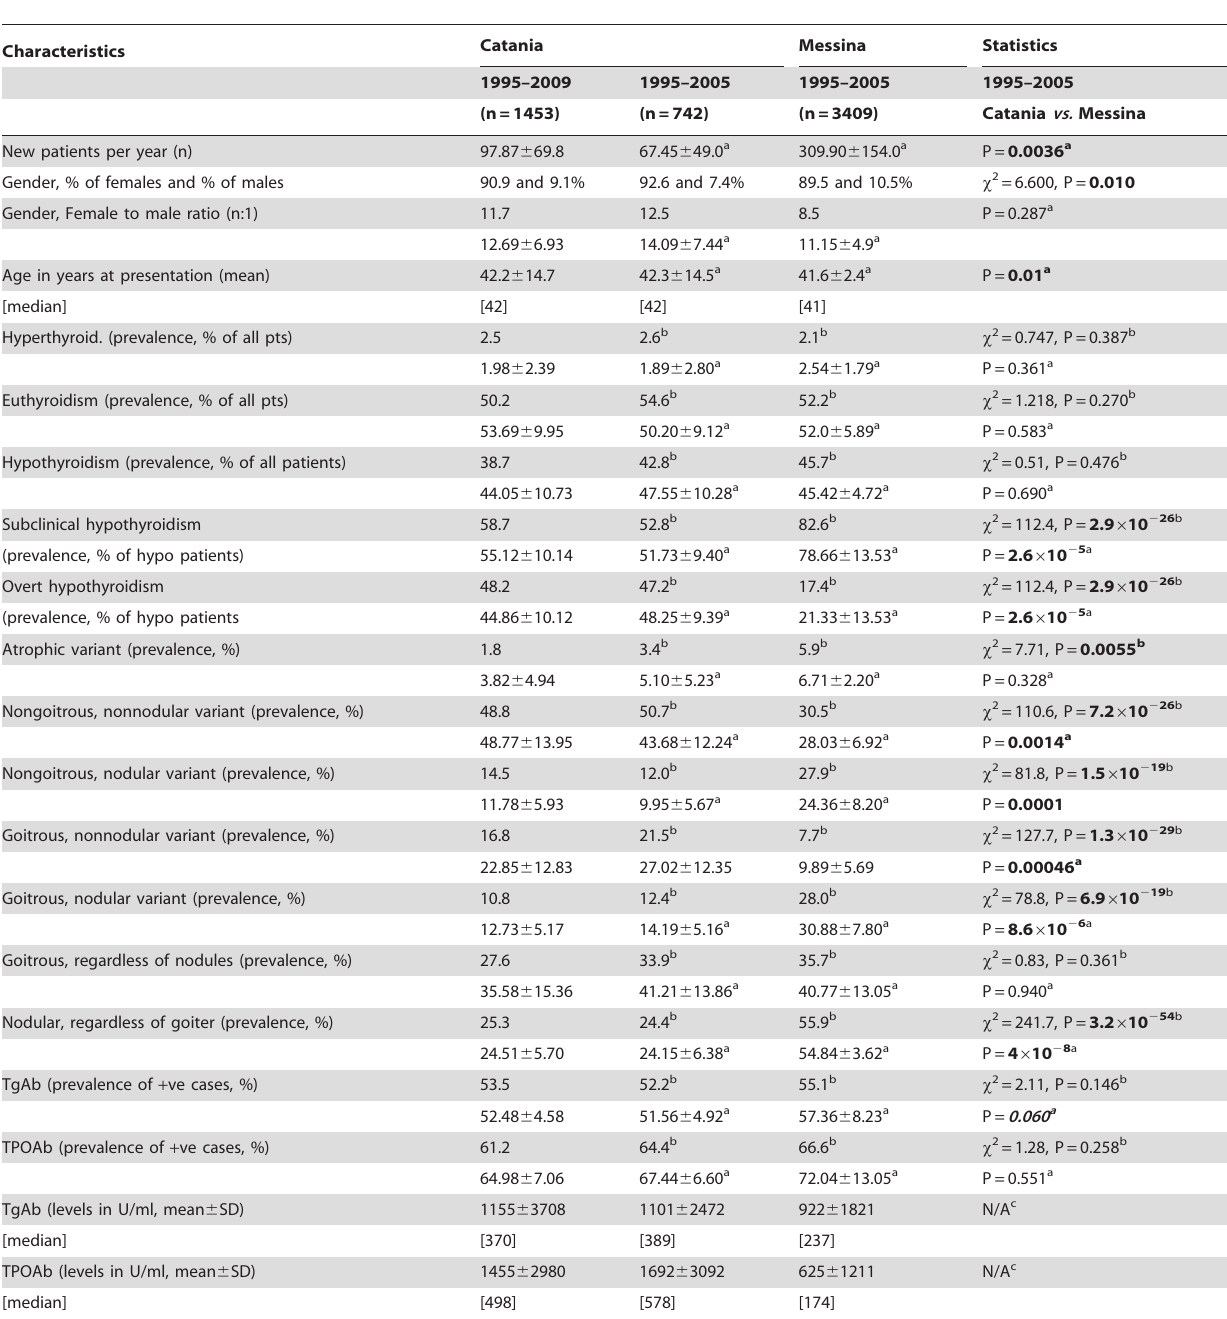
Table 1. Clinical, biochemical and ultrasonographic characteristics of Hashimoto’s thyroiditis patients observed at two endocrine divisions (University Hospital of Catania or Messina) during the indicated